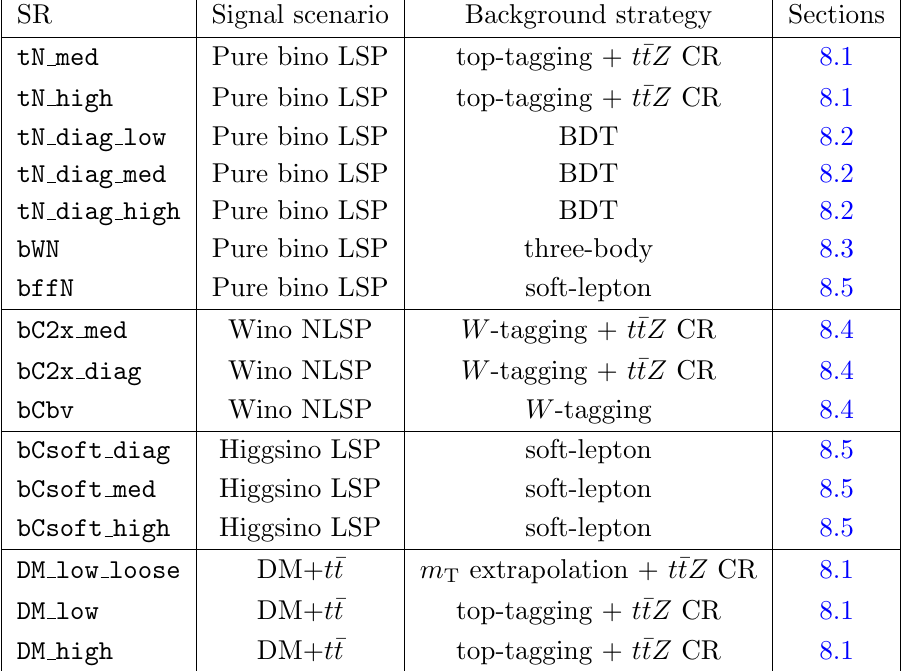
Table 12 . Overview of various approaches for the background estimates in all signal regions together with the targeted signal scenario. The t (cid:22) t + Z ( ‘‘ ) control region (CR) described in section 8.6 is also de(cid:12)ned in the top-tagging and W -tagging approaches, except for the bCbv SR where the contribution of the t (cid:22) t + V background is